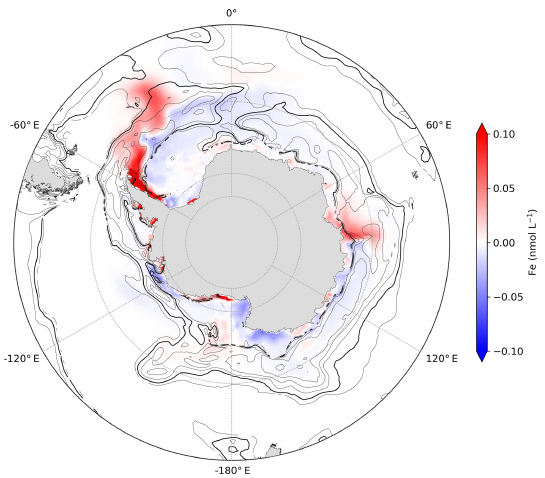
Figure 5. Difference in surface Fe concentrations between the ICB- SURF and the SOLUB5 experiments in winter (June, July, and Au- gust) in the Southern Ocean, south of 45 ◦ S. The black isoline repre- sents the mixed layer depth at 120m, and the gray isolines represent mixed layer depth shallower than